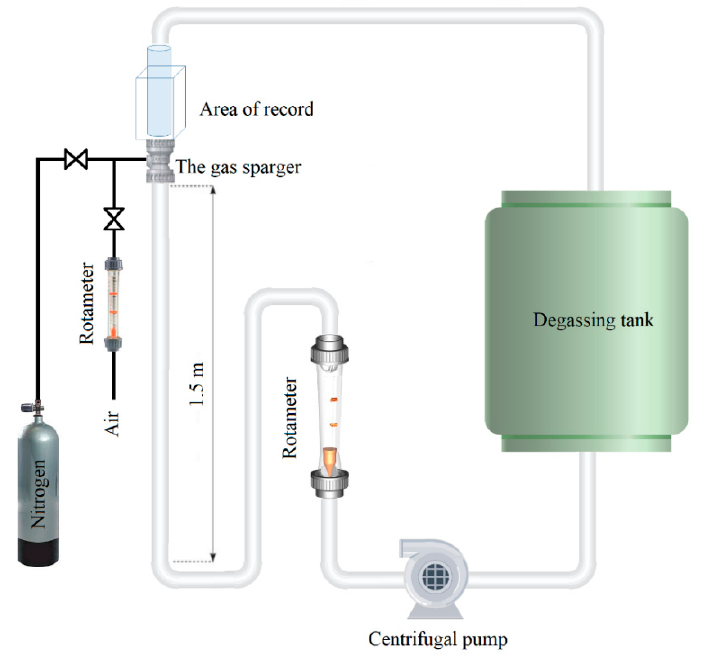
Figure 2. Laboratory CLR equipped with the DAF sparger.